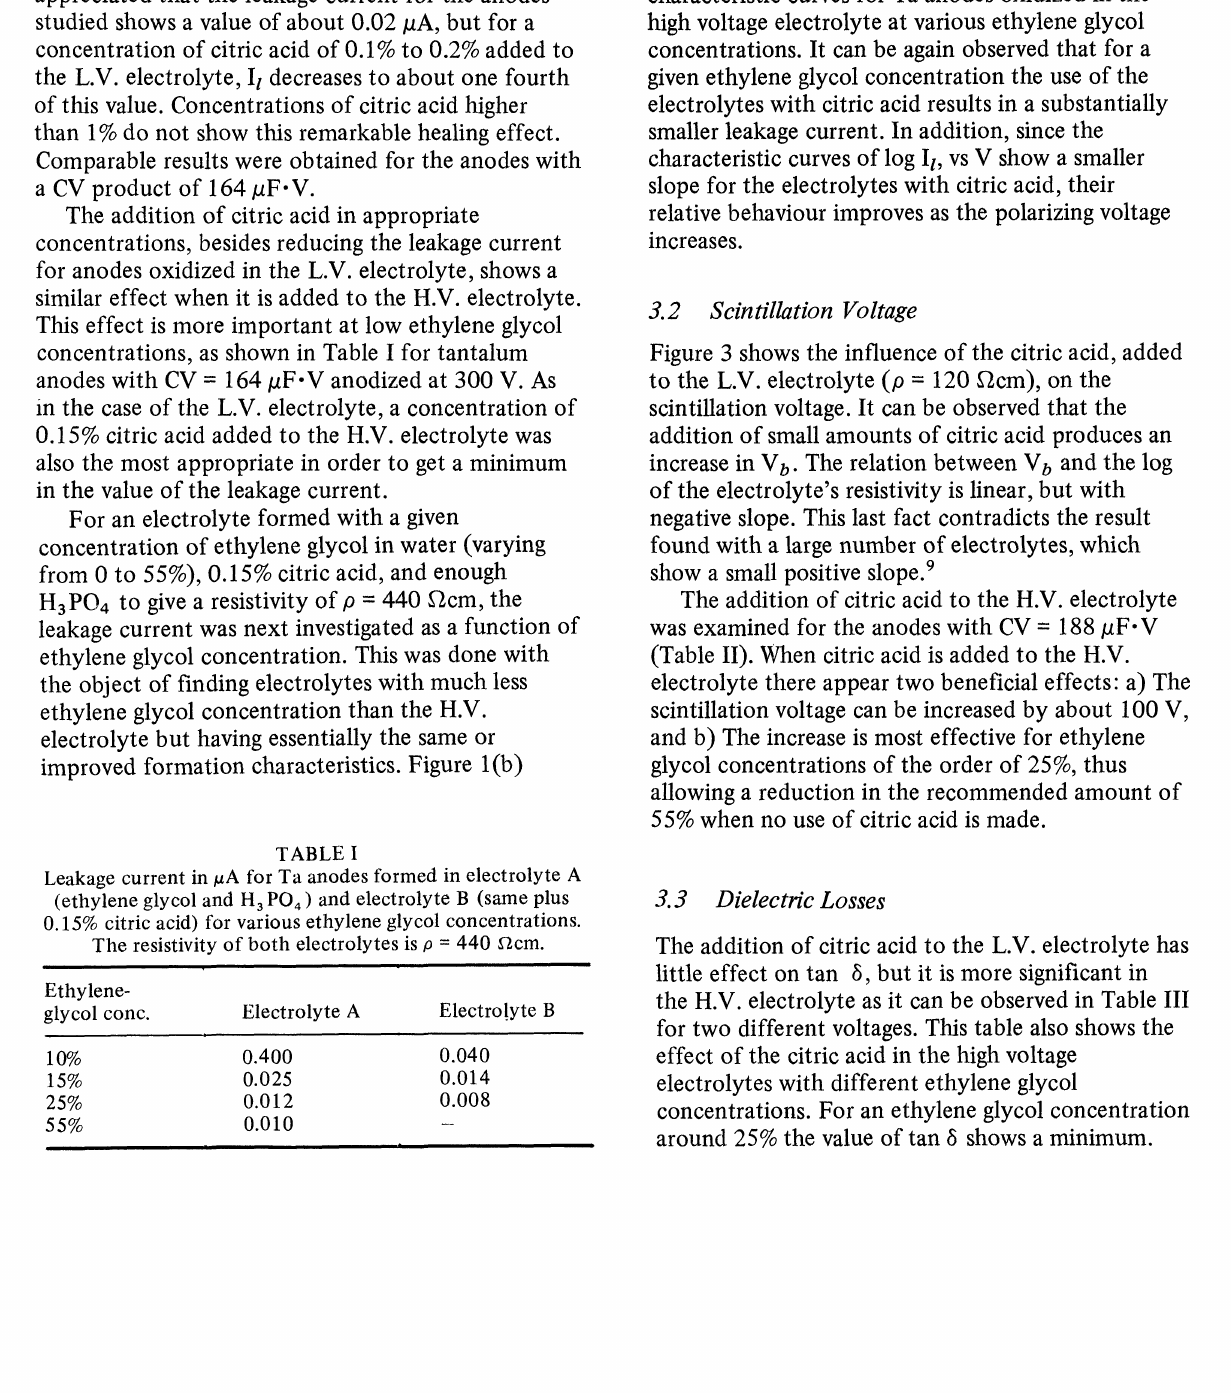
Leakage current in taA for Ta anodes formed in electrolyte A (ethylene glycol and H PO and electrolyte B (same plus 0.15% citric acid) for various ethylene glycol concentrations. The resistivity of both electrolytes is o 440 s2cm. Ethylene- glycol